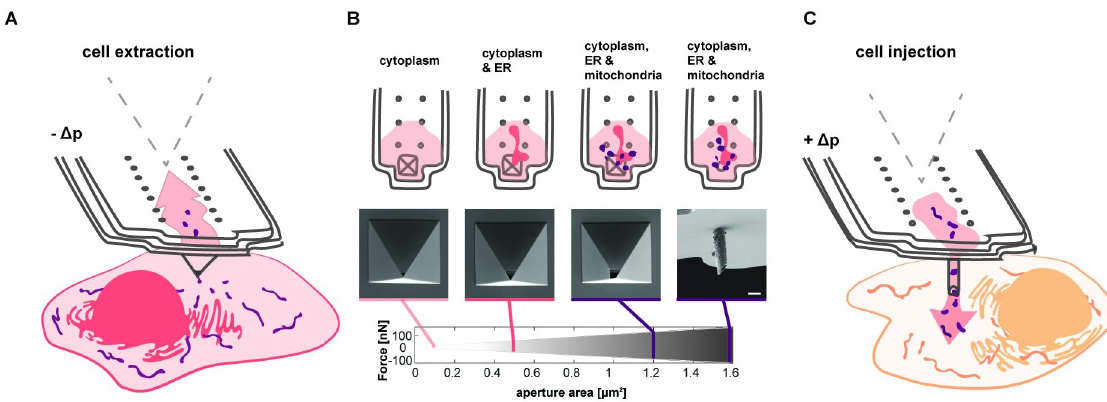
Fig 1. Schematic of organelle extraction and injection using FluidFM. ( A ) Extraction volumes are tuned by applying negative pressure ( − Δ p). Probe prefilling with octadecafluorooctane allows for optical and physical separation of the extract within the cantilever. ( B ) Selective extraction of organelle components by tuning the aperture size and thus the applicable range of applied fluidic forces. Top row: schematic view of extracted cell components inside the cantilever. Middle row: scanning electron microscopy images of cantilever apexes with different apertures. Bottom row: range of applicable fluidic forces with adapted FluidFM cantilevers. Scale bar: 2 μ m. ( C ) Schematic of mitochondria injection into single cells by applying positive pressure (+ Δ p) once the cantilever was inserted into the recipient cell. The data underlying Fig 1B can be found in S1 Data. ER, endoplasmic